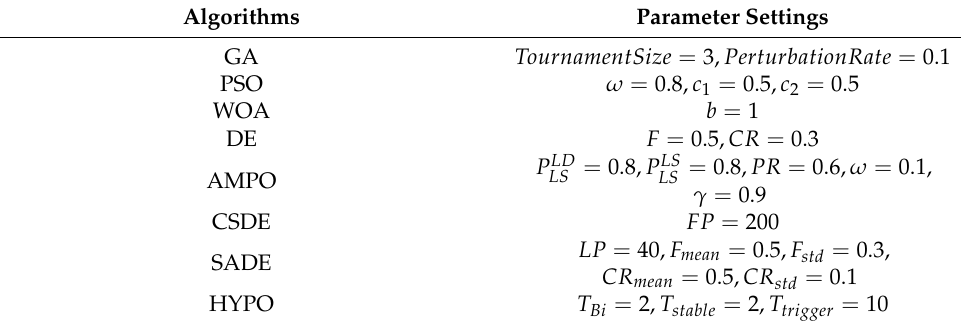
Table 1. The Parameter Settings of Compared